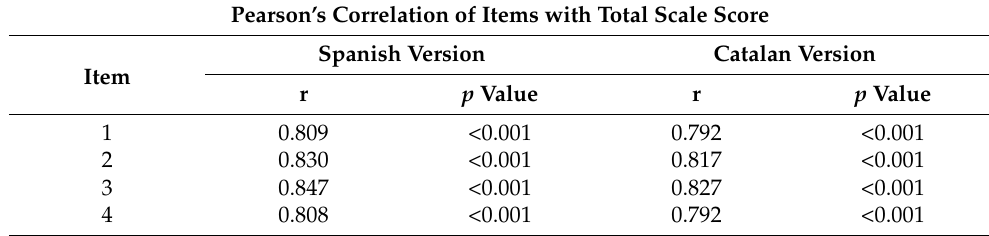
Table 4. Pearson’s correlation coefficients of items with whole scale